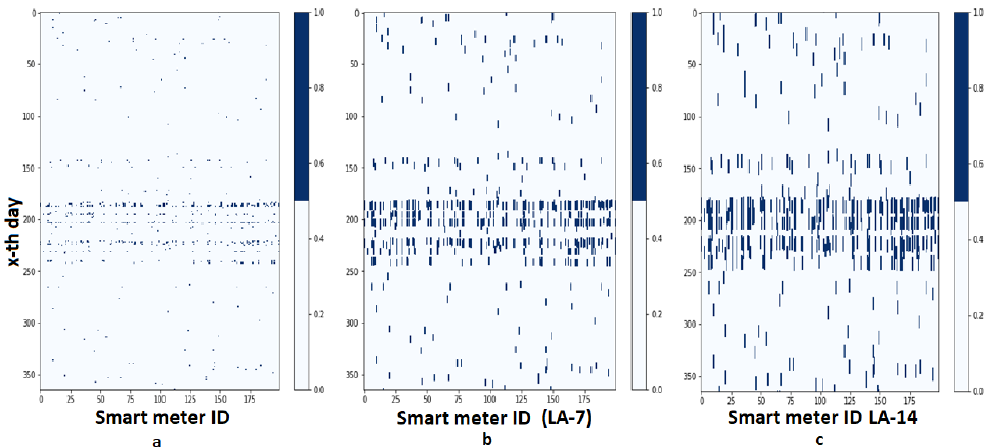
Figure 6. Anomaly Map Number of Smart meters and Day Number ( a ) Original statistical model, ( b ) With Look-ahead seven days (LA-7), ( c ) With Look-ahead 14 days (LA-14).